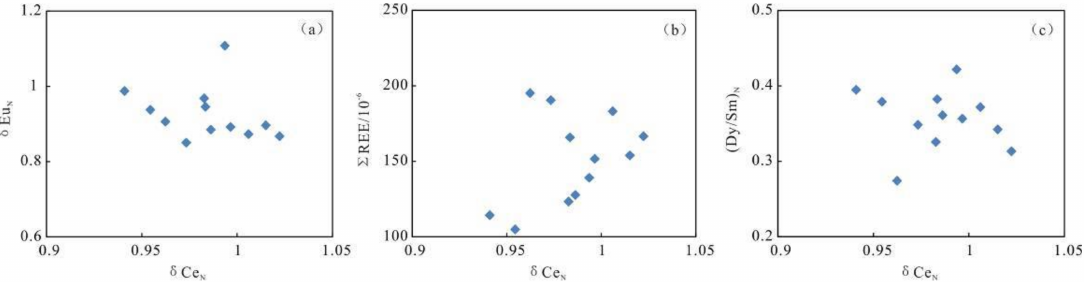
Figure 8. Relationship between δ Ce N and δ Eu N , total rare earth elements ( Σ REE), and (Dy/Sm) N of oil shale